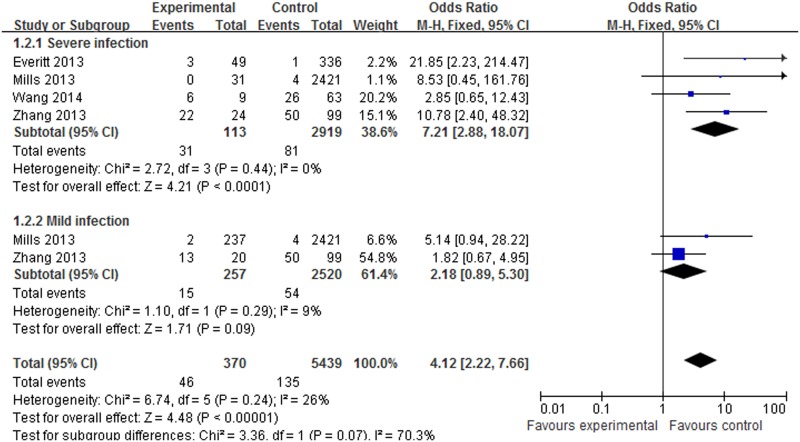
The forest plot for the association between SNP rs12252 of IFITM3 and influenza susceptibility in the homozygote comparison (CC vs. TT), subgroup analysis by different severity.